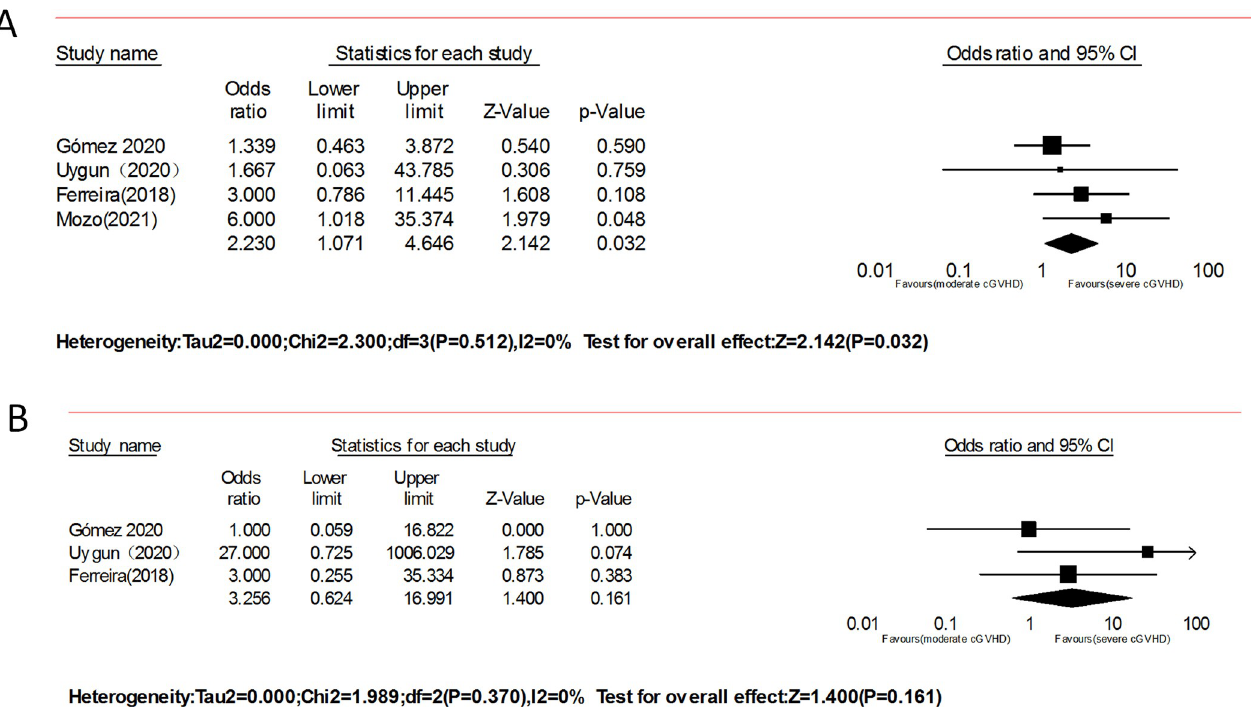
Fig 8. Forest plots of the overall response (ORR) of moderate vs. severe after ruxolitinib